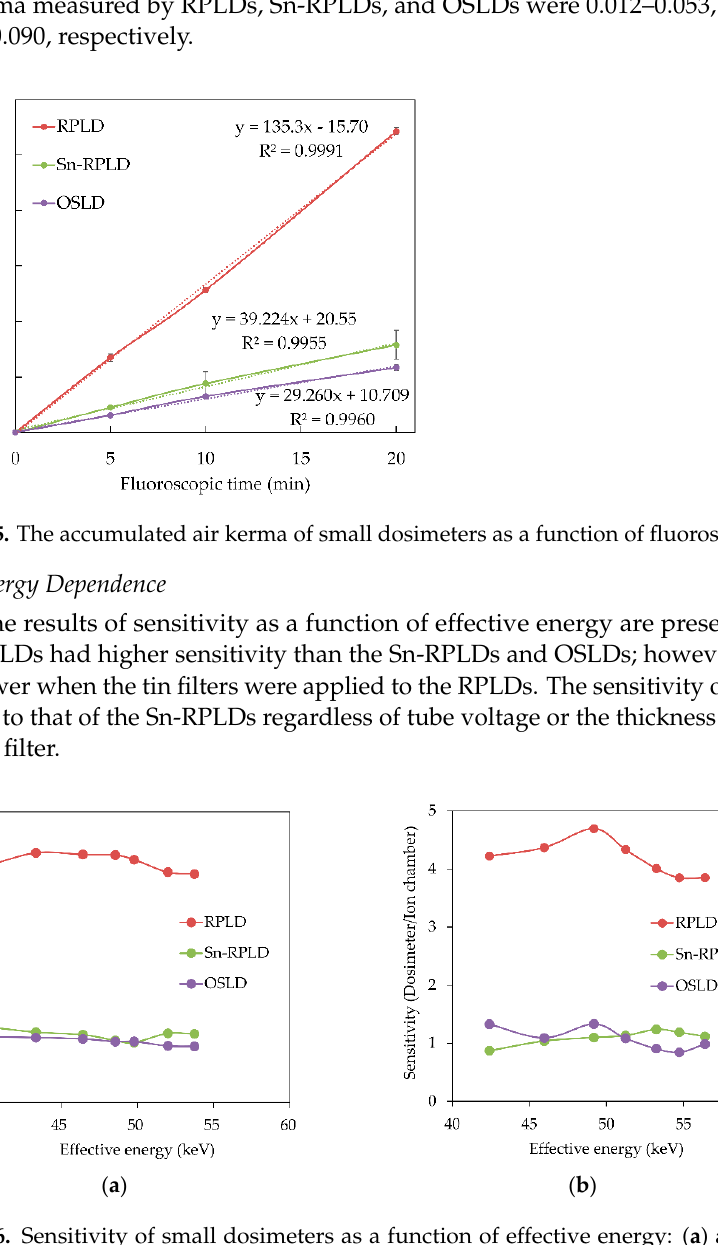
( b ) Figure 7. Relative dose values as a function of the dosimeter angle: ( a ) horizontal direction and ( b ) vertical direction. 3.4. Eye Lens Dose Measurement That Simulated an ERCP Physician The air kerma obtained from RPLDs, Sn-RPLDs, and OSLDs pasted on the radiopro- tective glasses of the physician phantom is shown in Figure 8.